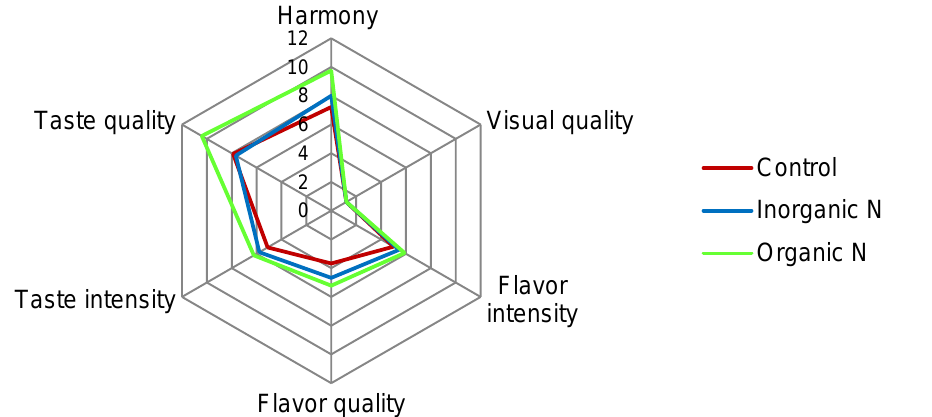
Figure 3. Sensory spider diagram of the different wines elaborated after 5 months of final MLF. Minor score indicated better quality of each attribute.